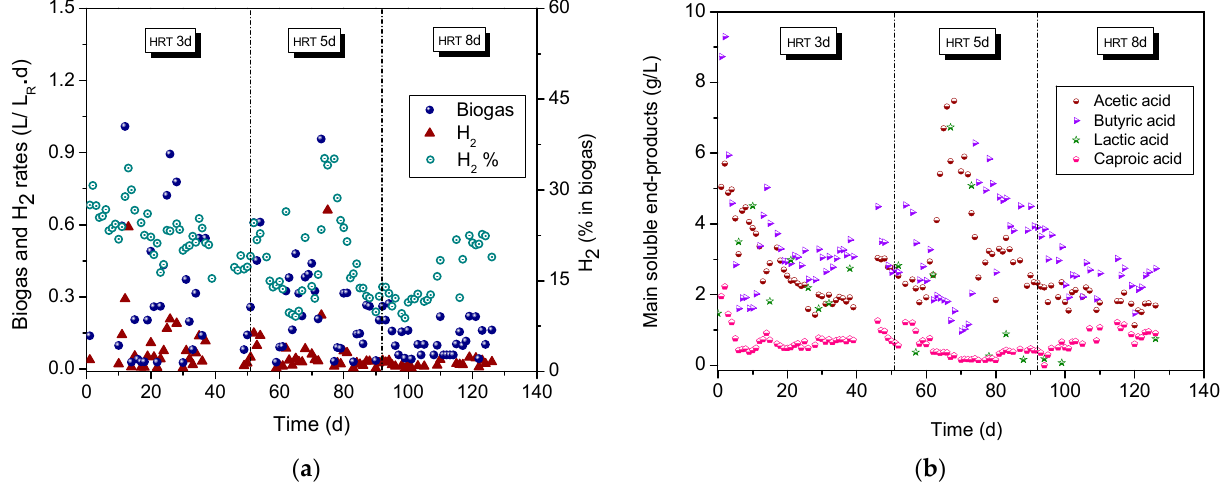
Figure 5. Evolution of ( a ) biogas and hydrogen production rates and content and ( b ) the main soluble end products during acidogenesis for each HRT tested.